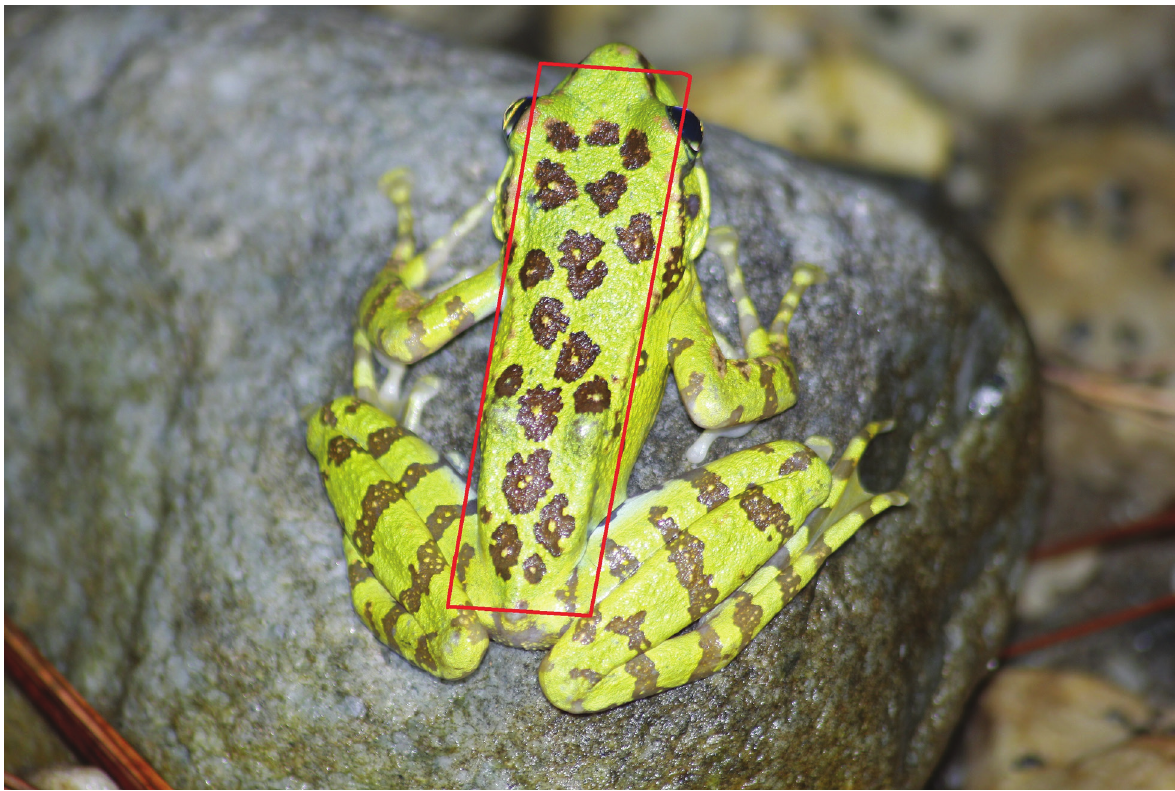
Figure 2. Region of interest (ROI) for natural pattern is marked in red